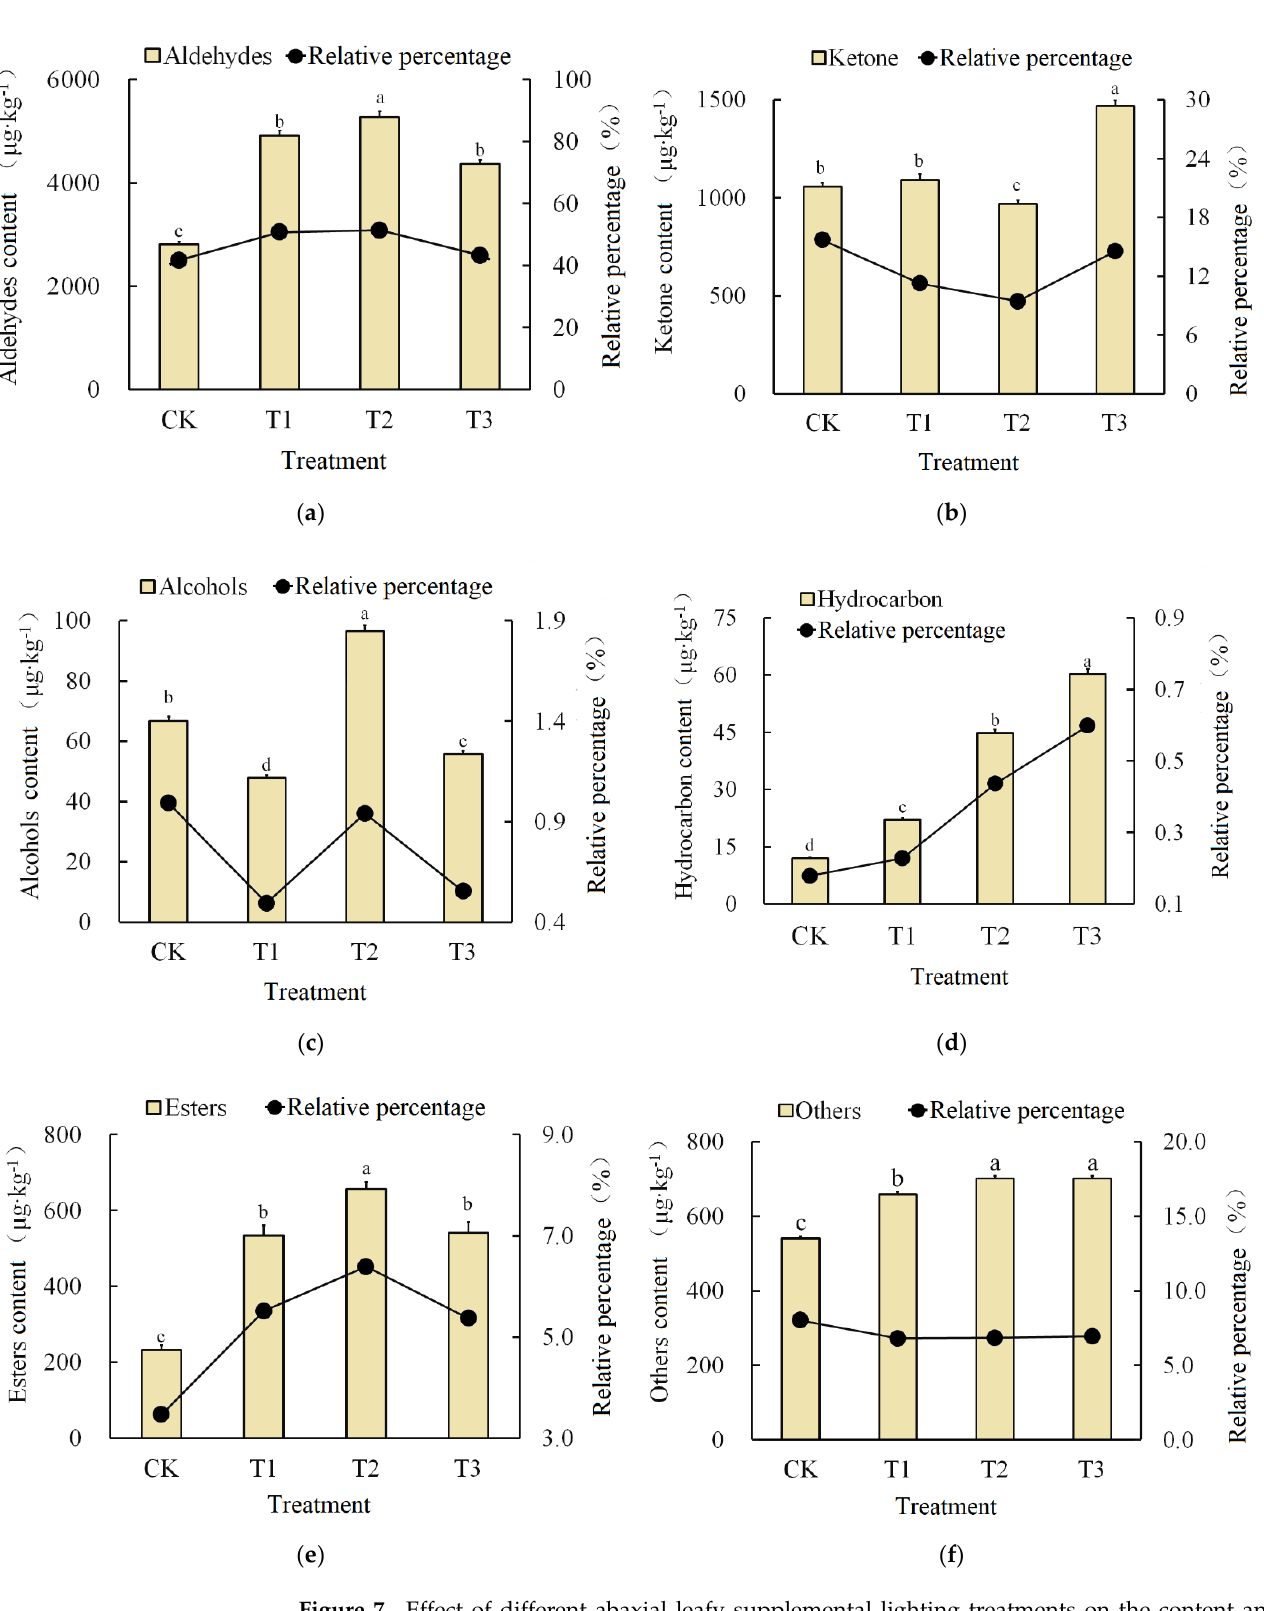
Figure 7. Effect of different abaxial leafy supplemental lighting treatments on the content and relative percentage of various volatile substances of cherry tomato fruit. ( a ) Aldehydes; ( b ) ketone; ( c ) alcohols; ( d ) hydrocarbon; ( e ) esters; ( f ) others. Tukey’s HSD test was used, and vertical bars represent standard errors of the means ( n = 15). Different letters indicate significant differences at p < 0.05 according to Tukey’s HSD